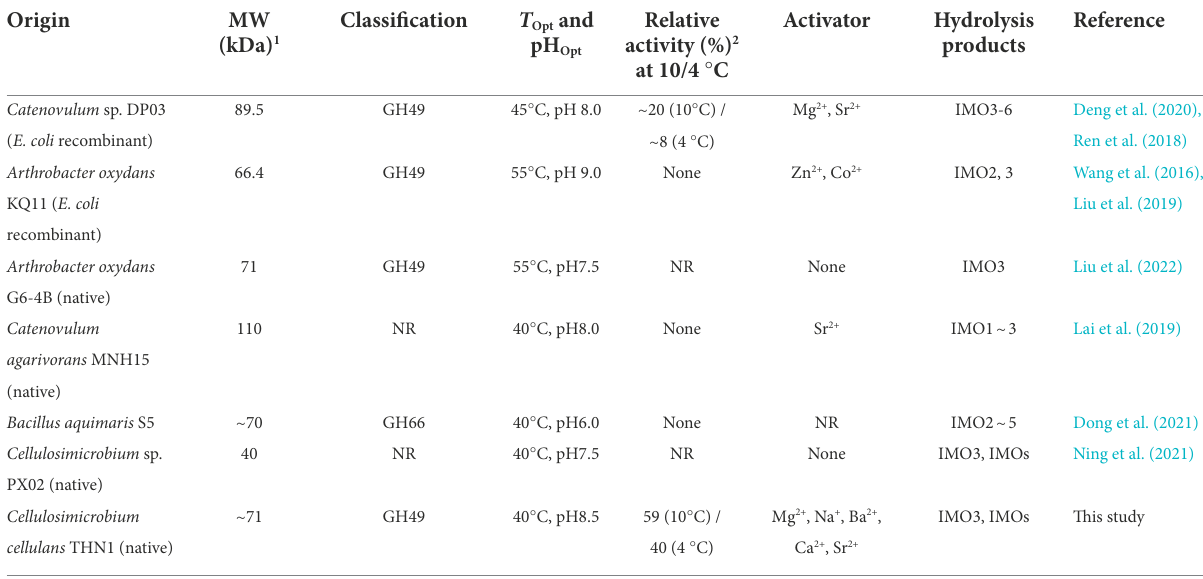
TABLE 6 Comparison information on the dextranases from